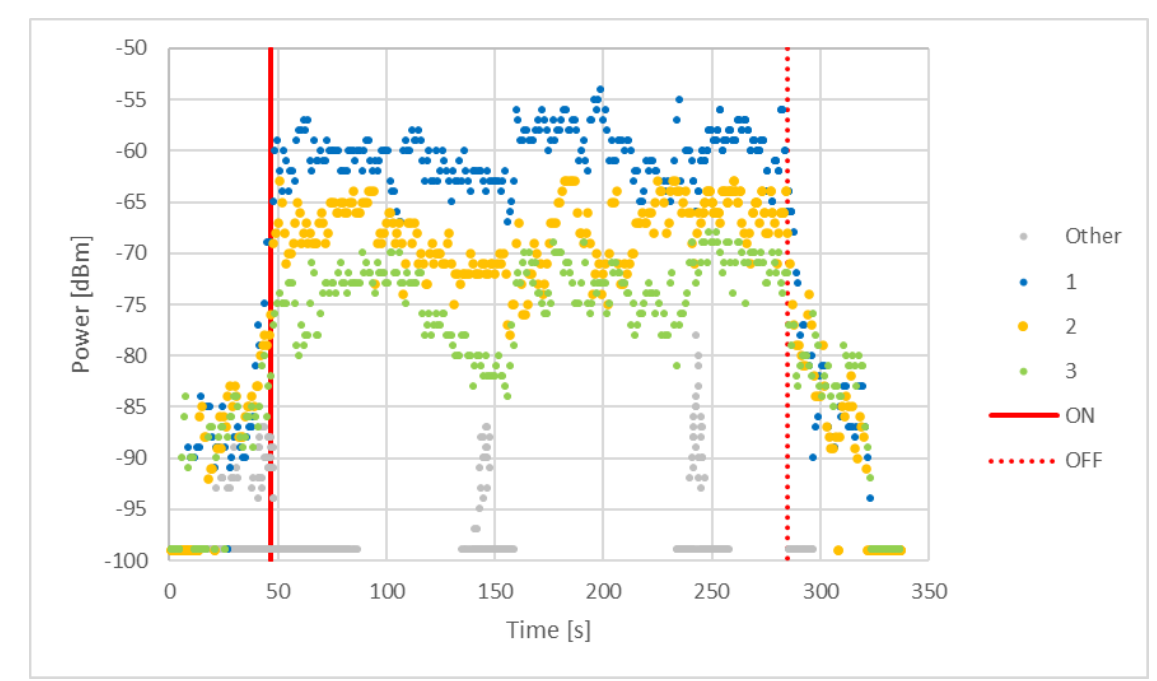
Figure 9. Power level inside a vehicle during the signal sampling tests.